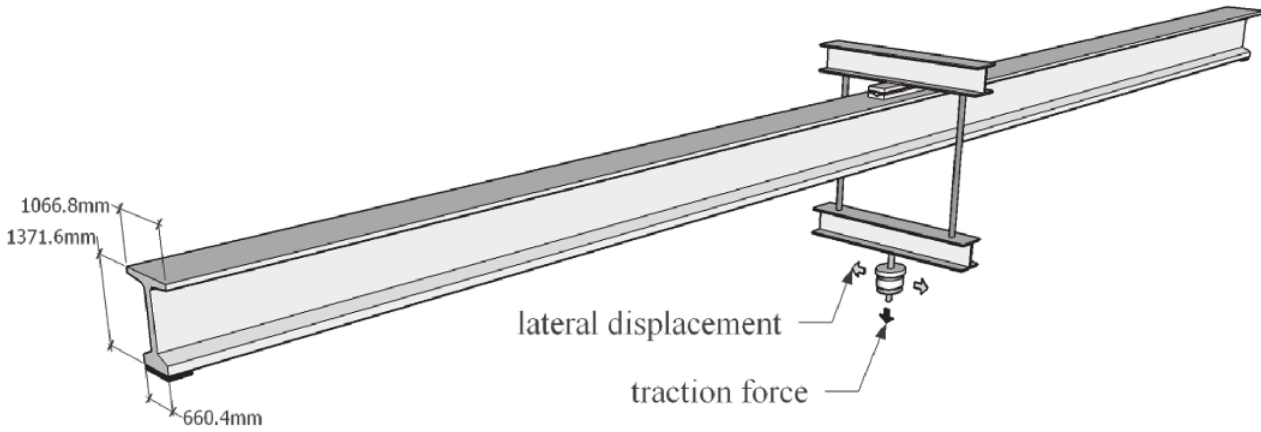
Schematic representation of the beam tested by Hurff and Kahn